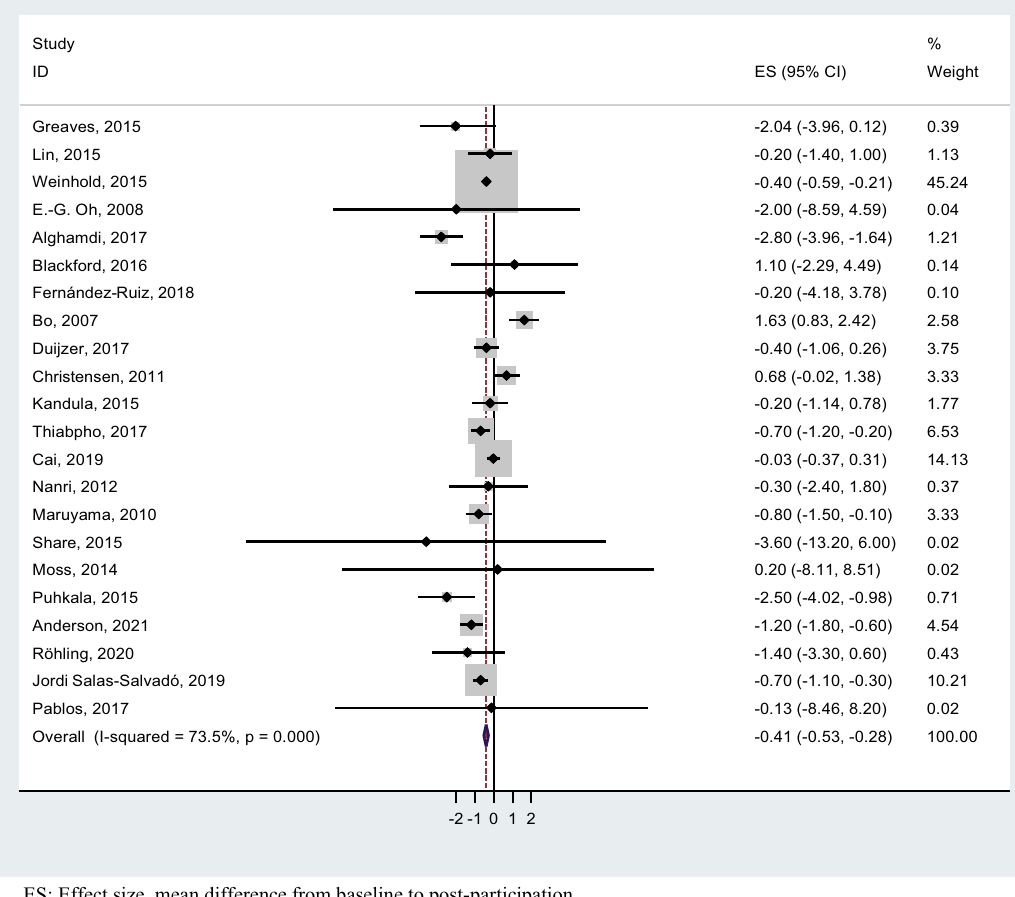
Figure 3. Meta-analysis of weight loss outcome in control group participants in lifestyle randomized controlled